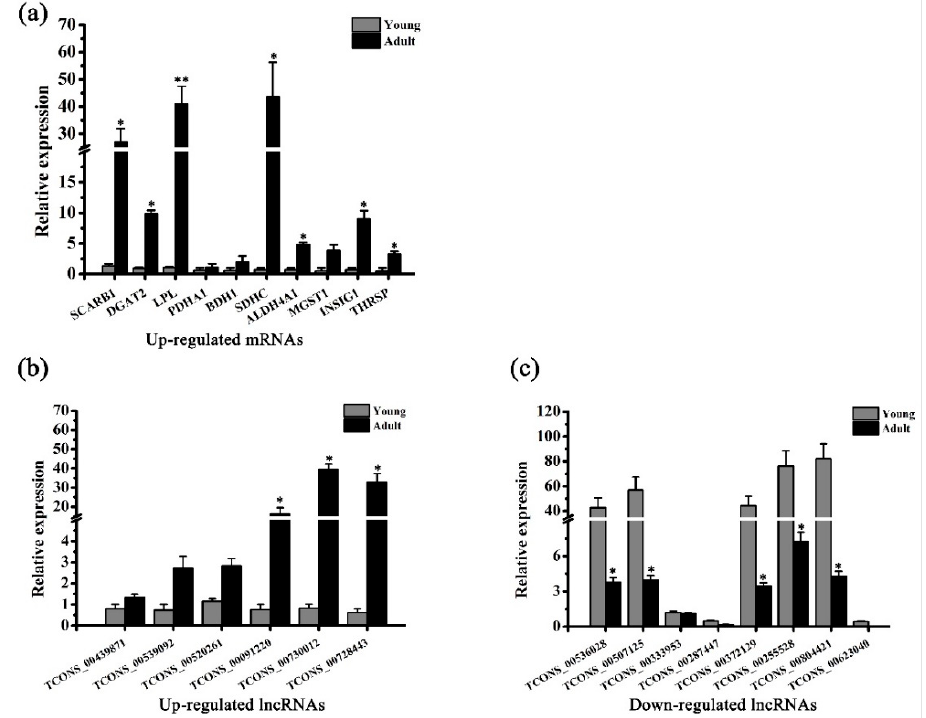
Figure 2. Validation of differentially expressed mRNAs and lncRNAs by qRT-PCR. ( a , b , and c ) Expression patterns of ten upregulated mRNAs, six upregulated lncRNAs, and eight downregulated lncRNAs in adipose tissues of young and adult buffalos. The RNA expression levels are normalized to those of GAPDH . Comparison was analyzed by Student’s t test or nonparametric test. Data are presented as mean ± SD ( n = 3, *, p < 0.05, **, p < 0.01).